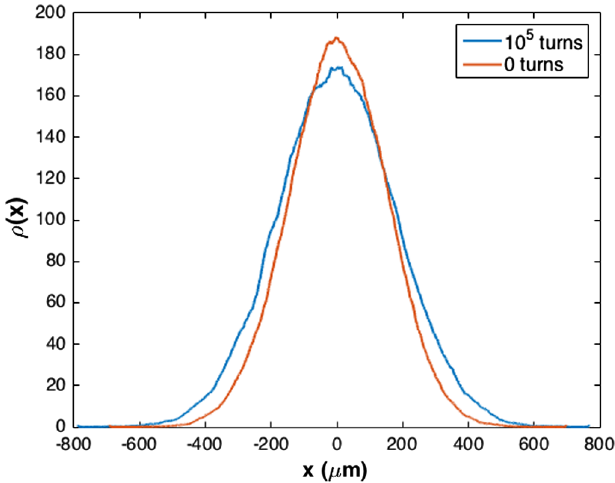
FIG. 11. Transverse position distribution at turns 0 and 10 5